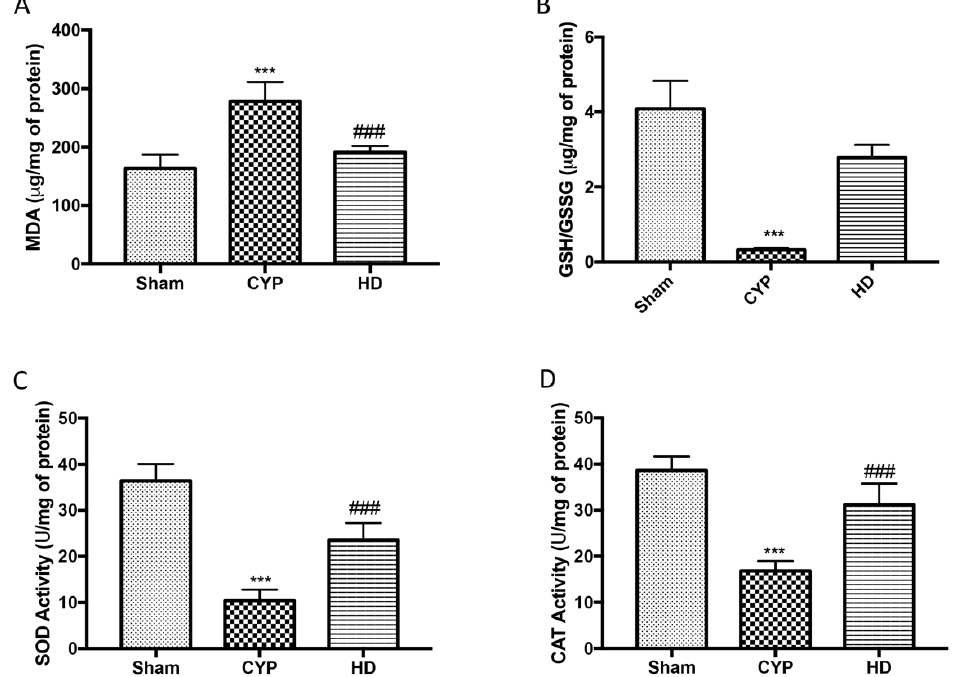
Figure 3. Effect of HD on oxidative stress in CYP-induced chronic cystitis: ( A ) Malondialdehyde content (MDA); ( B ) reduced glutathione/oxidized glutathione ratio (GSH/GSSG); ( C ) superoxide dismutase (SOD); ( D ) catalase. Data are expressed as the mean ± SD of five animals for each group; *** p < 0.001 vs. Sham; ### p < 0.001 vs.